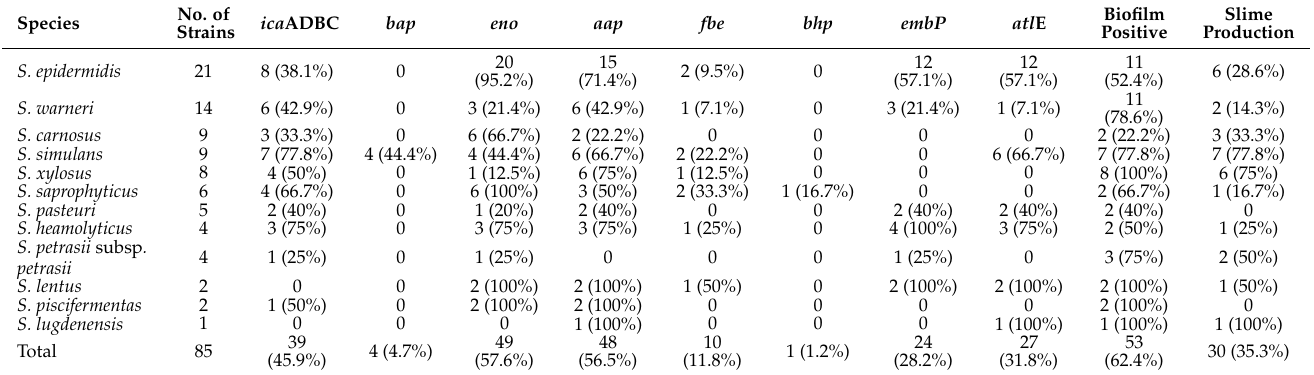
Table 3. Detection of the biofilm-associated genes among the CoNS